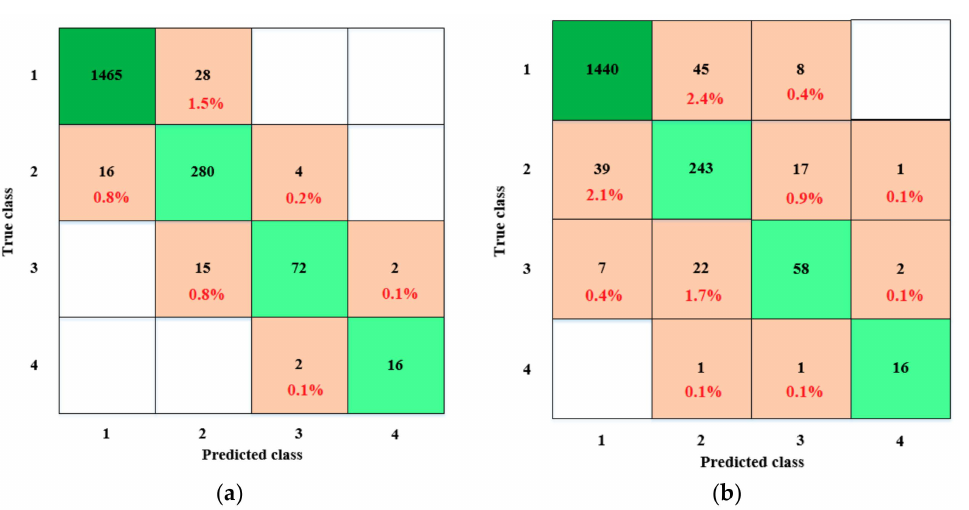
Figure 7. Confusion matrix of brake intention using random forest. ( a ) Prediction horizon (time) = 0.5 s; ( b ) prediction horizon (time) = 1